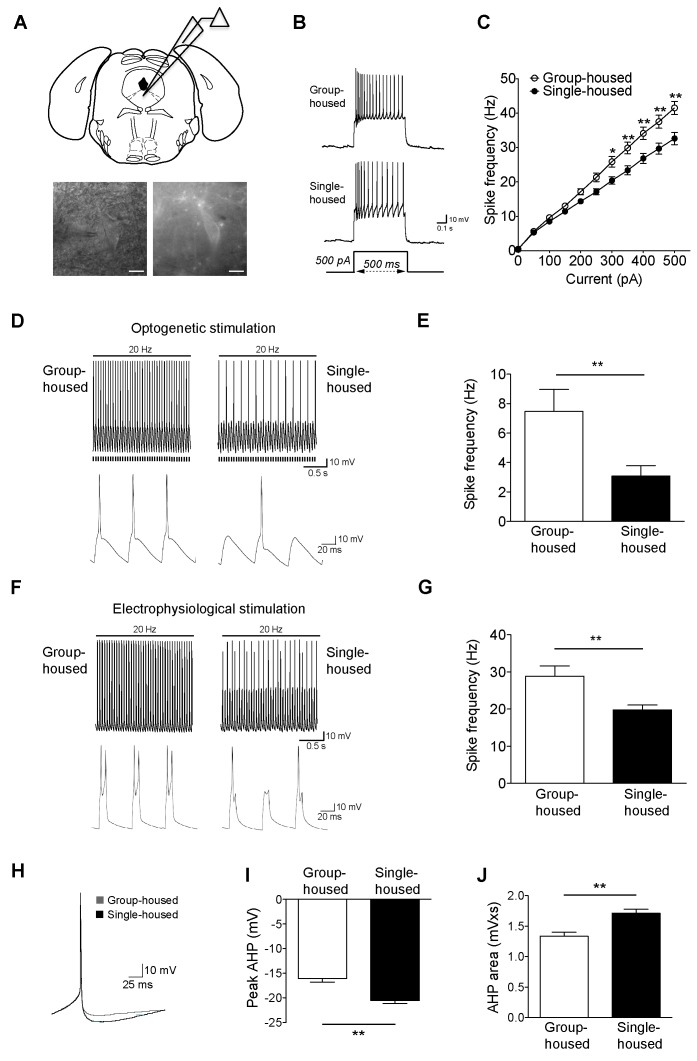
Reduced firing of dorsal raphe 5-HT neurons after chronic social isolation is accompanied by an increase in afterhyperpolarization (AHP).(A) Schematic representation of a coronal brainstem section (above) comprising dorsal raphe nucleus (adapted from Paxinos and Franklin, 2001) where 5-HT neurons are recorded. IR-DIC and EYFP fluorescence images (below) of a dorsal raphe 5-HT neuron being approached by a recording pipette. Scale bars, 10 μM. (B) Current-clamp traces of a 5-HT neuron from a group-housed (above) and a single-housed (below) mouse in response to a 500 pA depolarizing step. (C) Input-output curve showing spike frequency (Hz) of 5-HT neurons in response to a series of depolarizing current (pA) injections. The firing frequency (Hz) of 5-HT neurons from single-housed mice (n = 38 neurons) is reduced compared to 5-HT neurons from group-housed mice (n = 33 neurons) indicating reduced excitability (two-way repeated-measures ANOVA, effect of housing, F
(1690) = 9.19, p=0.003; Newman-Keuls posthoc test, *p<0.05, **p<0.01) (D) Current-clamp recordings of a 5-HT neuron from a group-housed mouse (left, inset below) and a single-housed mouse (right, inset below) showing action potential firing in response to 20 Hz optogenetic stimulation by blue light. Note that the neuron from the group-housed mouse is able to respond with 20 Hz firing frequency to blue light whereas the neuron from the single-housed mouse responds with a 7 Hz firing frequency. (E) The frequency (Hz) of action potentials in response to optogenetic stimulation is reduced in 5-HT neurons from single-housed mice (n = 20 neurons) compared to neurons from group-housed mice (n = 17 neurons) (unpaired t-test, *p<0.05). (photocurrents; group-housed: −343 ± 32.3 pA, single-housed: −269 ± 29.4 pA, p=0.1) (F) Current-clamp recordings of a 5-HT neuron from a group-housed mouse (left, inset below) and a single-housed mouse (right, inset below) showing action potential firing in response to 20 Hz electrophysiological stimulation. The neuron from the group-housed mouse produced spike doublets in response to the strong electrophysiological stimulation (left inset). The neuron from the single-housed mouse responded with missing spikes (right inset). (G) The frequency (Hz) of action potentials in response to electrophysiological stimulation is reduced in 5-HT neurons from single-housed mice (n = 14 neurons) compared to neurons from group-housed mice (n = 13 neurons) (unpaired t-test, **p<0.01). (H) The first spike of the 25 pA depolarizing step of a current-clamp trace from each 5-HT neuron from group-housed (n = 33 neurons) and single-housed (n = 37 neurons) mice is averaged in order to obtain the resulting trace showing the AHP difference. The peak value of the AHP (mV) (I) and AHP area (mVxs) (J) are greater in 5-HT neurons from single-housed mice, relative to group-housed mice (unpaired t-test, **p<0.01). Data are represented as mean ± S.E.M.